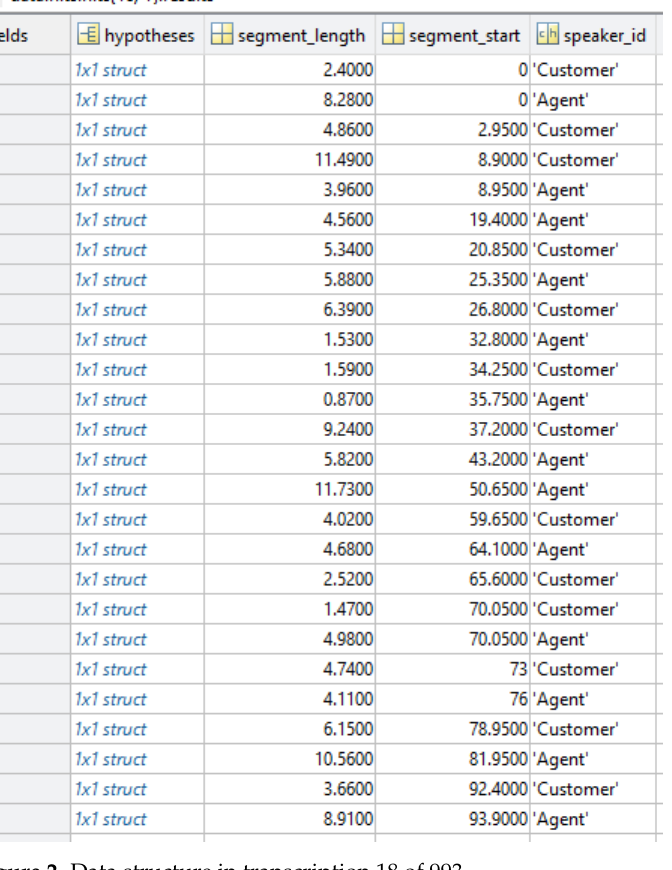
Figure 2. Data structure in transcription 18 of 993.